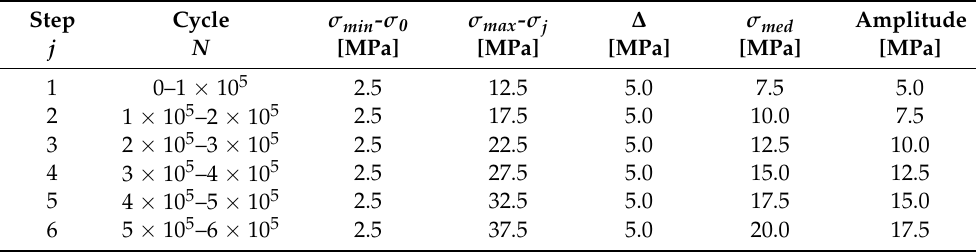
Table 5. Fatigue test parameters by the Locati